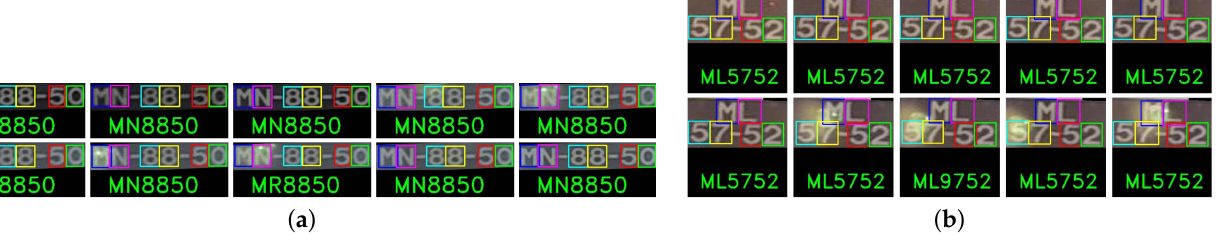
Figure 11. The recognition of license plates using image sequences. For each example, ( a ) MN8850 and ( b ) ML5752, among the 10 frames, 9 frames are successful and only 1 failure occurred (at 2nd row, 3rd column) because of a strong reflection of